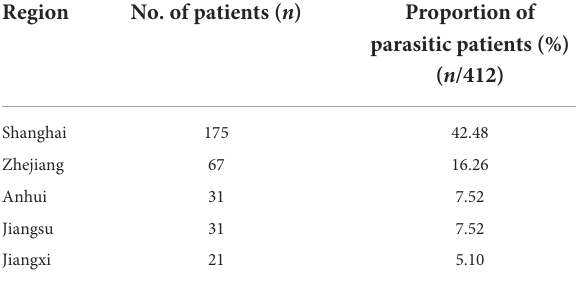
TABLE 2 The main origins of parasite-infected patients.